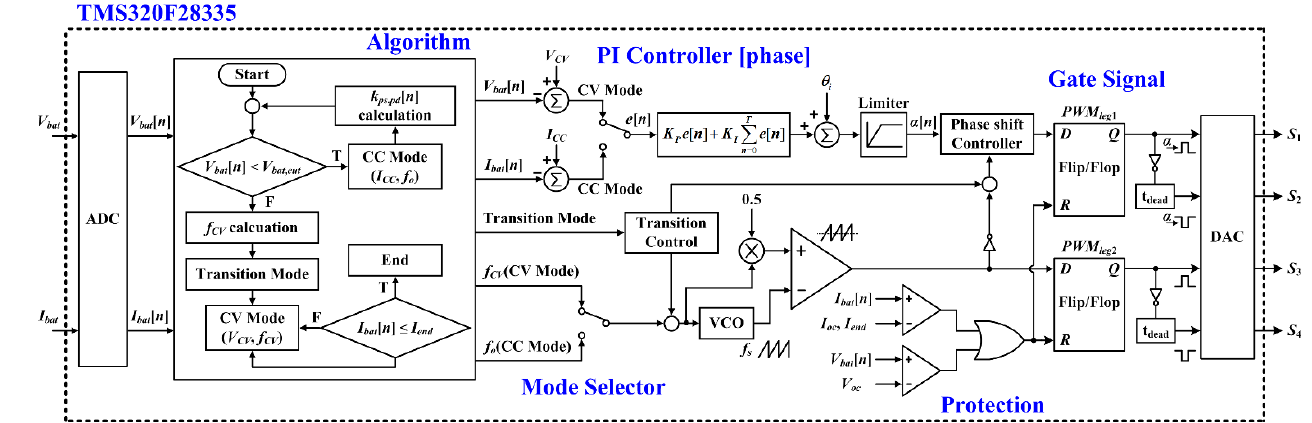
Figure 7. Block diagram of the digital controller for the proposed single-stage wireless battery charging circuit.